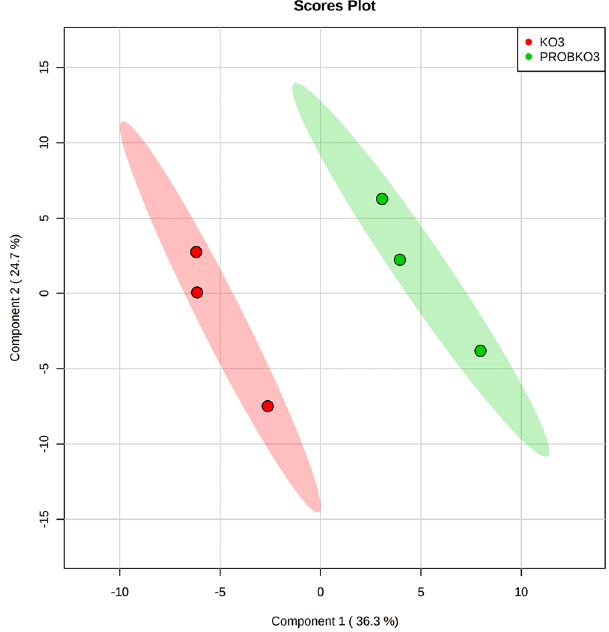
Figure 1. Partial least squares discriminant analysis of uremic toxins/retention solutes reveals separation between plasma metabolites from Oat3KO mice (KO3; red) and Oat3KO mice treated with probenecid (PROBKO3; green). The dots represent each individual uremic toxin/retention solute metabolite profile and the shaded areas represent the 95% confidence interval.